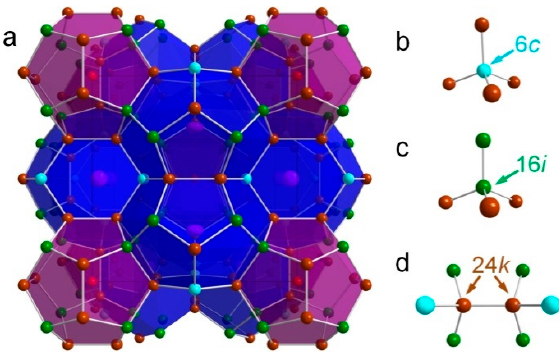
Figure 1. Crystal structure of type-I clathrate ( a ) and atomic environment (tetrahedral bonds) in different sites ( b ) 6 c ; ( c ) 16 i ; and ( d ) 24 k .